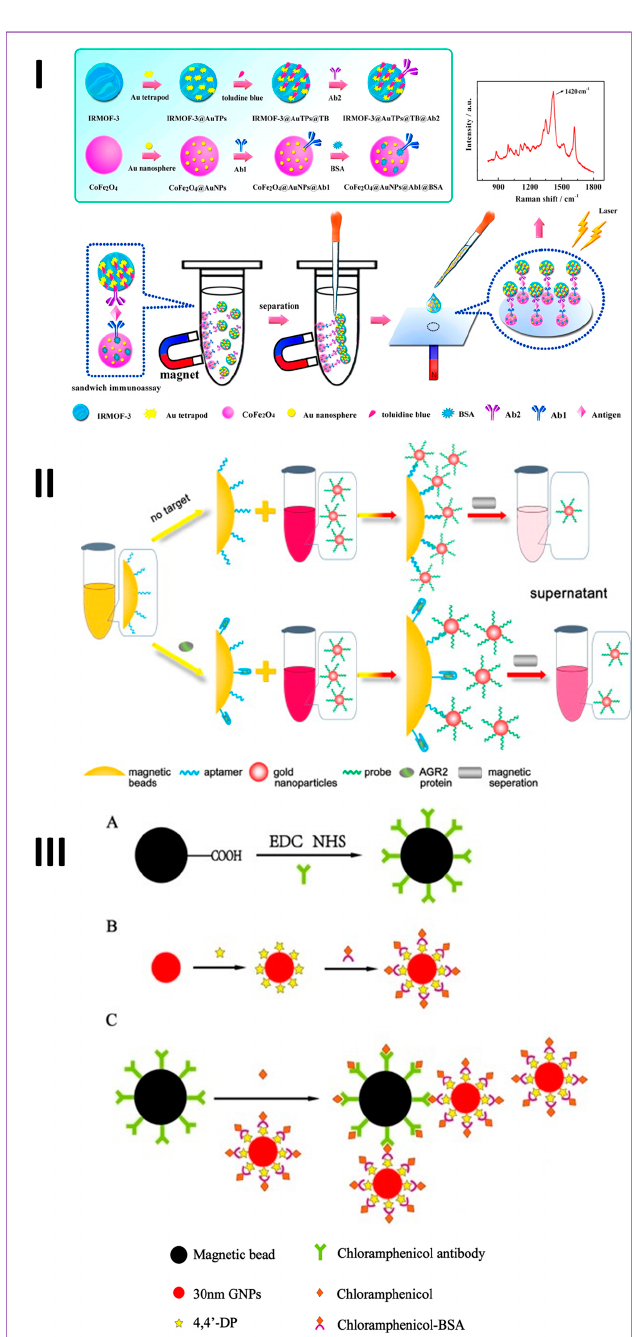
Figure 2. ( I ) Schematic representation of the surface-enhanced Raman spectroscopy (SERS)-based sandwich immunosensor for the detection of N-terminal pro-brain natriuretic peptides (NT-proBNPs). Reproduced with permission from Reference [54]. ( II ) Schematic representation of anterior gradient homolog 2 (AGR2) protein detection procedure. Reproduced with permission from Reference [60]. Copyright 2015